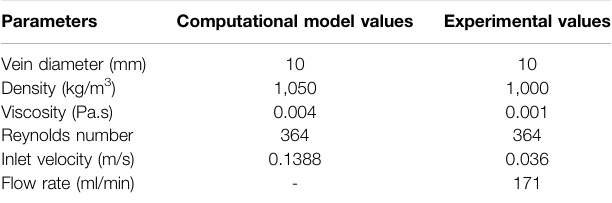
TABLE 4 | Parameter values used in the computational model and experimental study. Parameters